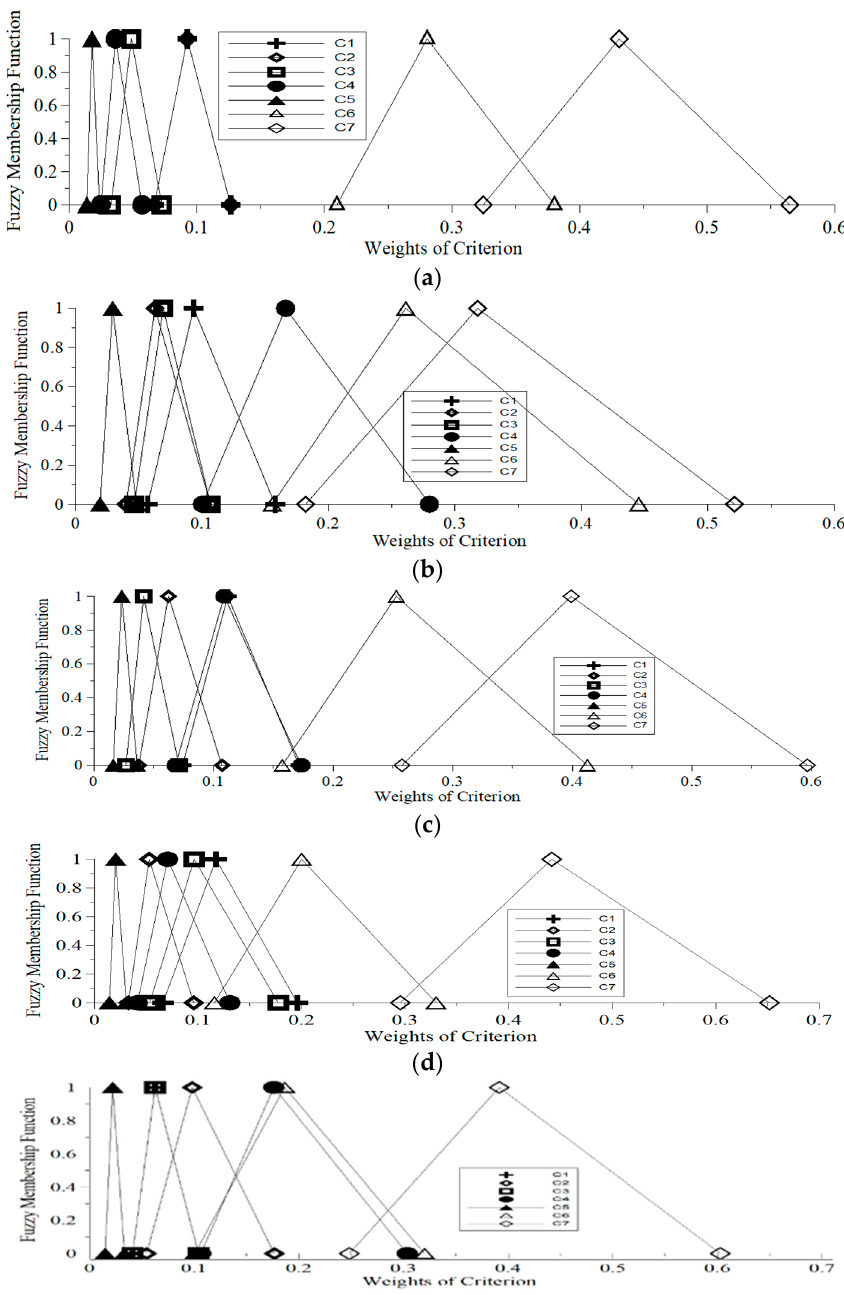
Figure 4. Fuzzy triangular weights for each criteria according to each expert ( a ) Expert 1 ( b ) Expert 2 ( c ) Expert 3 ( d ) Expert 4 ( e ) Expert